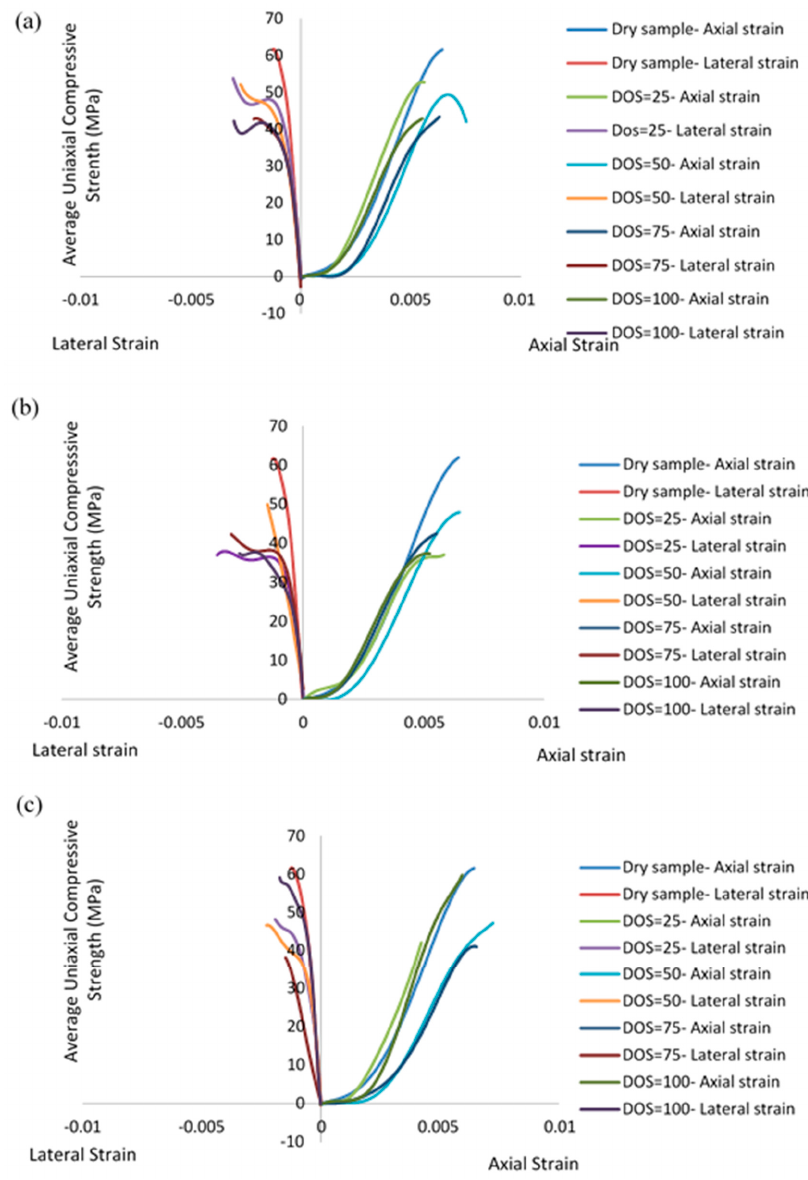
Figure 10. Stress–strain curves for ( a ) 10% NaCl concentration; ( b ) 20% NaCl concentration; ( c ) 25% NaCl concentration.